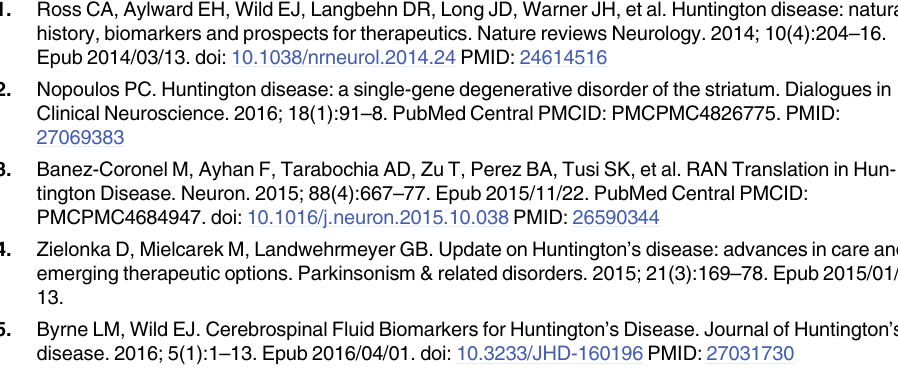
S1 Table. Dataset including clinical characteristics of study